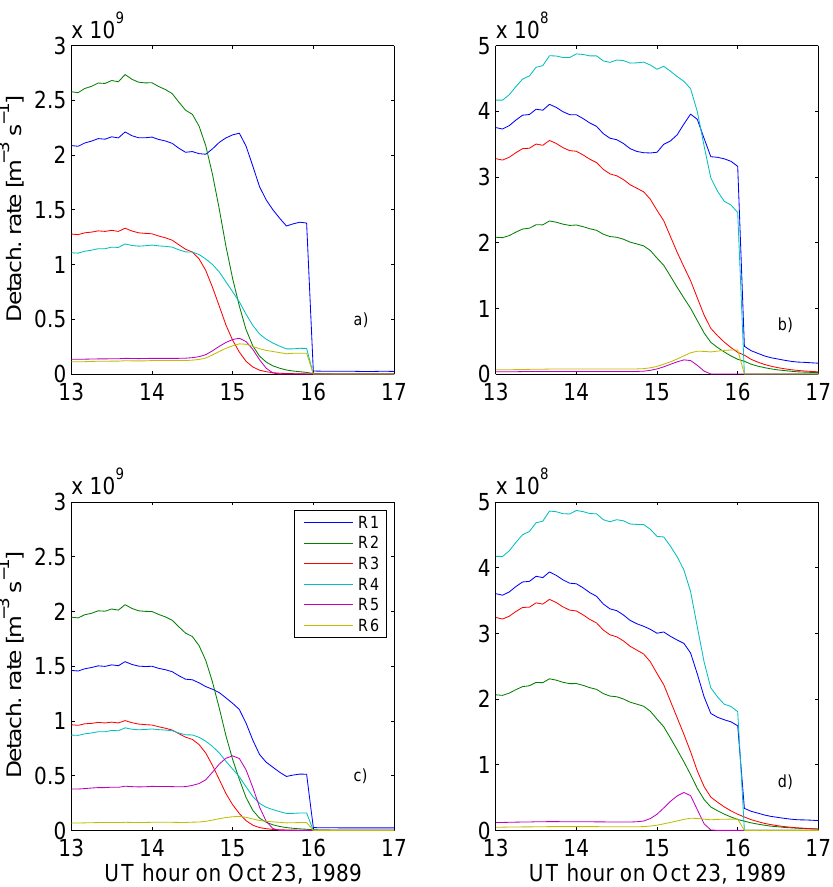
Fig. 11. Modelled rates of electron detachment from negative ions at (a) 65km and (b) 72km. The legend, which is the same for all panels, identifies the reactions listed in Table 1. Panels (c) and (d) are as (a) and (b), respectively, but with manually increased NO.